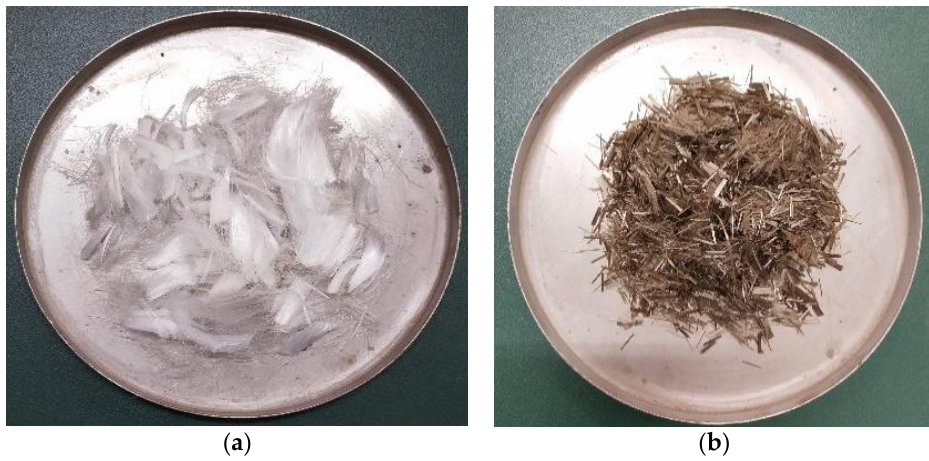
Figure 1. The appearance of fiber. ( a ) Polypropylene fiber and ( b ) basalt fiber. Table 2. Physical and mechanical properties of fibers [37].